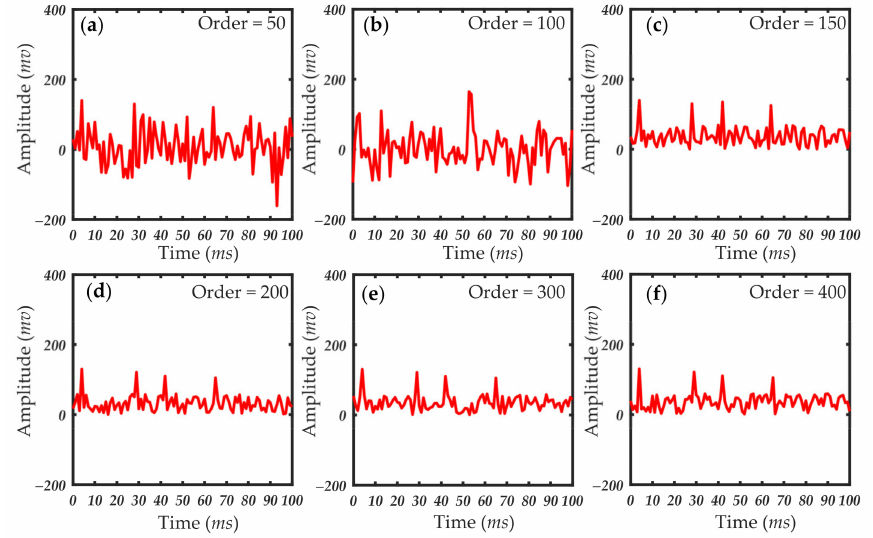
Figure 11. Results of 0.5 µ m particles under different filter order settings: ( a ) filter order = 50; ( b ) filter order = 100; ( c ) filter order = 150; ( d ) filter order = 200; ( e ) filter order = 300; ( f ) filter order =